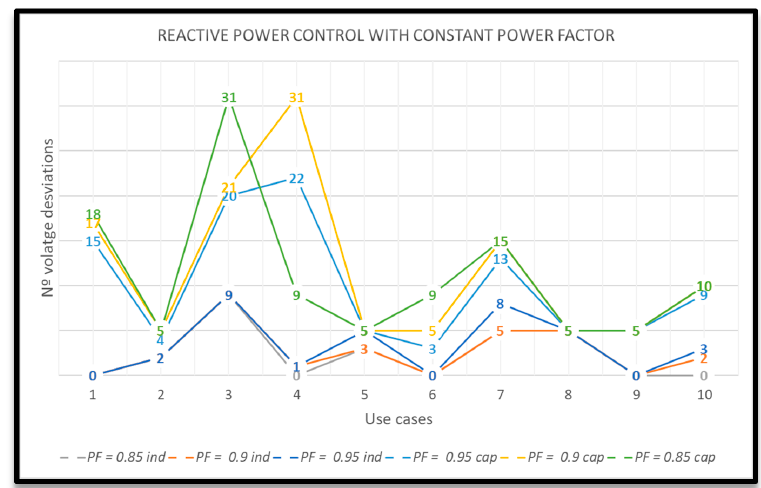
Figure 9. Reactive power control with constant power factor: Voltage deviations (More information see Table A6 in Appendix C).